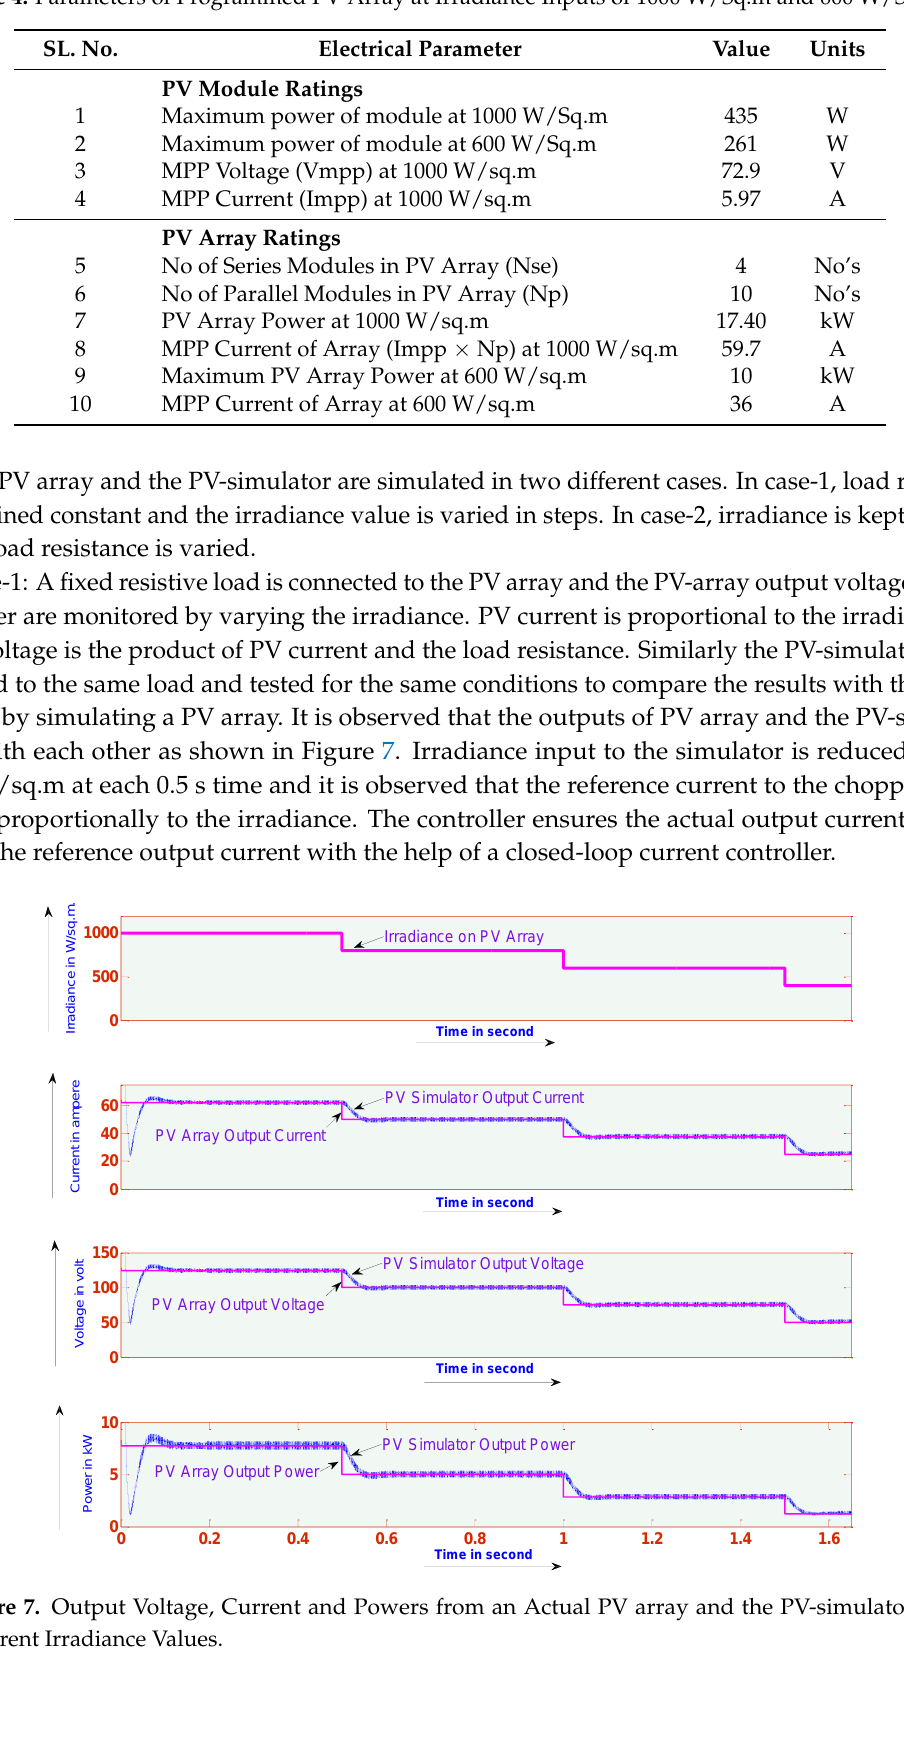
Figure 8. Output Voltage, Current and Powers from an Actual PV array and the PV-Simulator for at an Irradiance of 600 W/Sq.m.